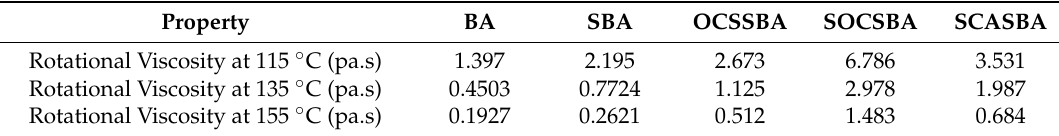
Table 5. The viscosity test results of BA, SBA, OCSSBA, SOCSBA, and SCASBA. Property BA SBA OCSSBA SOCSBA SCASBA Rotational Viscosity at 115 ◦ C (pa.s) 1.397 Rotational Viscosity at 135 ◦ C (pa.s) 0.4503 Rotational Viscosity at 155 ◦ C (pa.s)